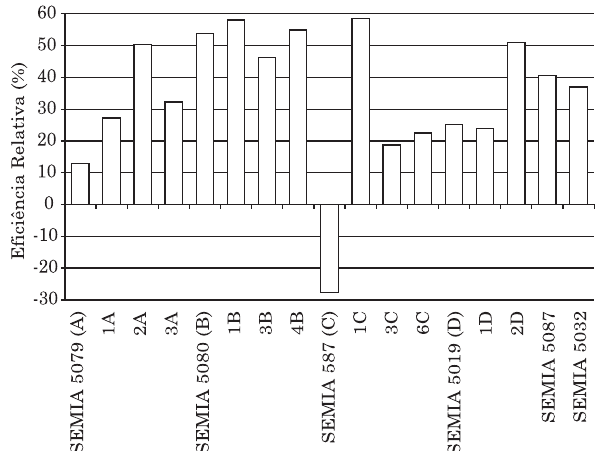
Figura 3. Índices de eficiência relativa dos tratamentos inoculados com estirpes e variantes de B.